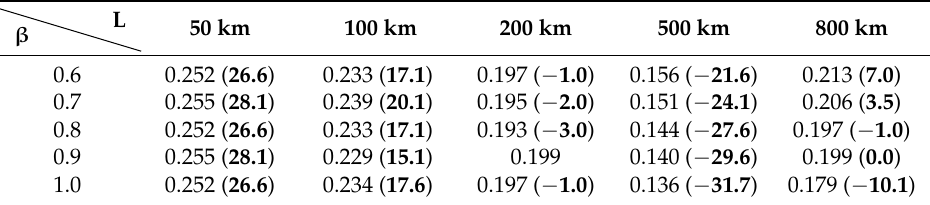
Table 7. Statistical results of the equitable threat score (ETS) for the sensitivity experiments for the case C-09. Their improvements (%) relative to Exp-A3 are in parentheses and set in boldface. L 50 km 100 km β